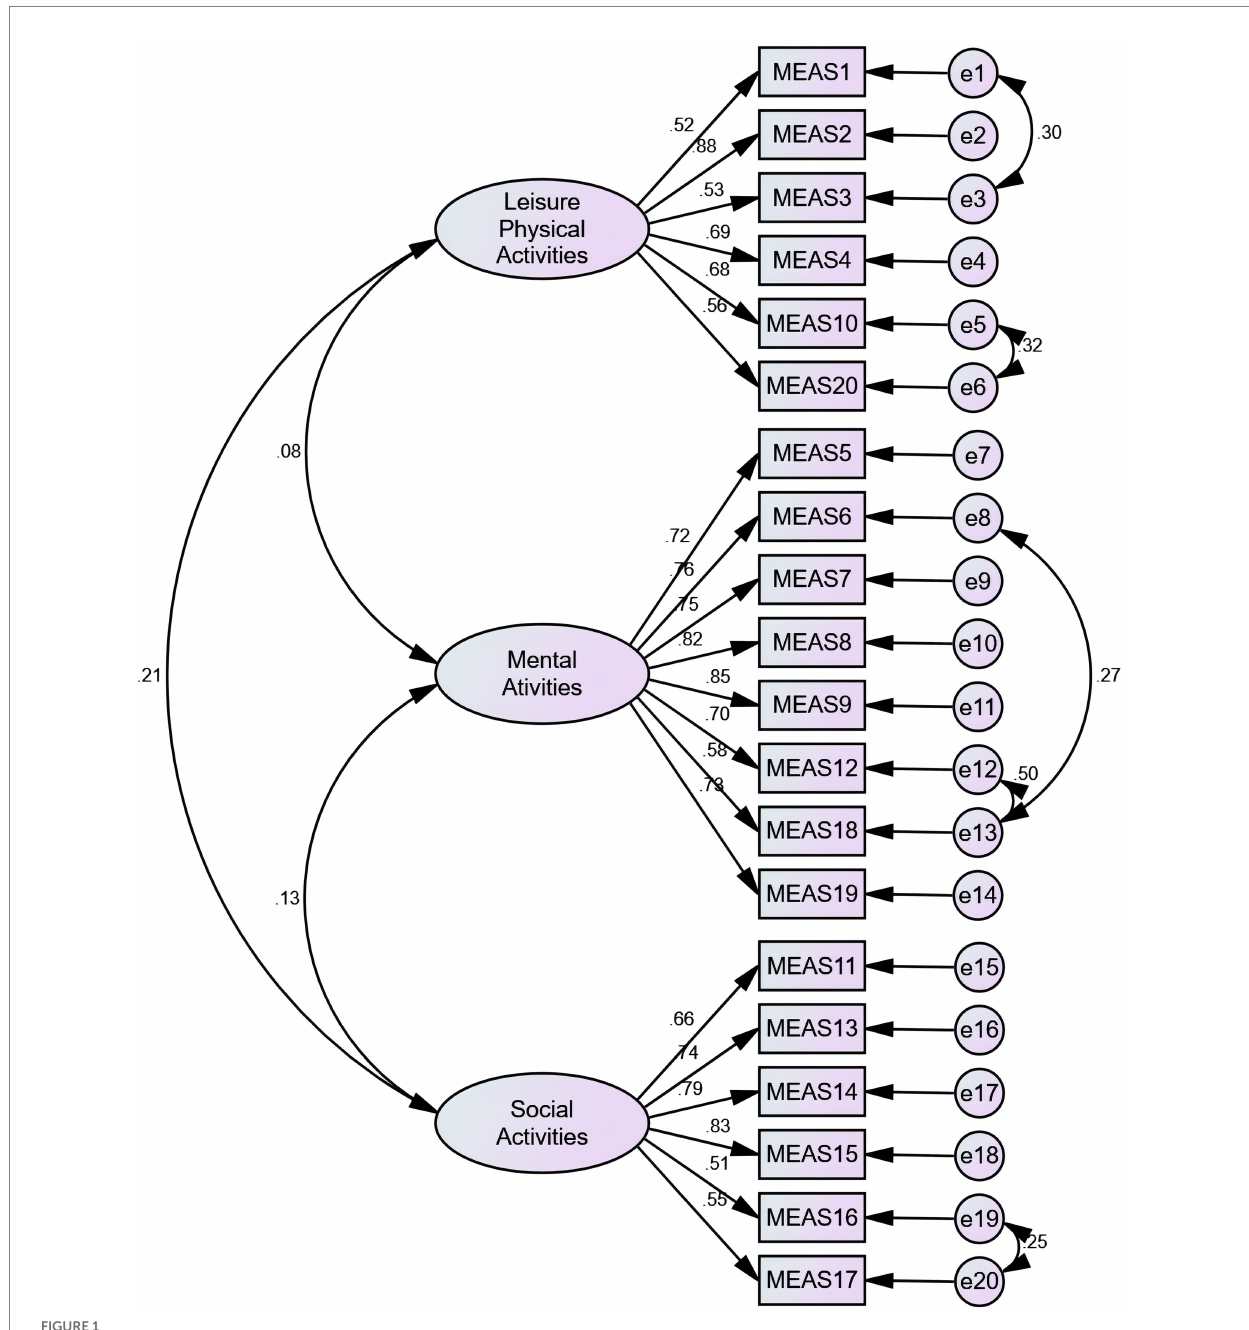
FIGURE 1 CFA of the modified three-factor model of the C-MEAS ( N = 230).